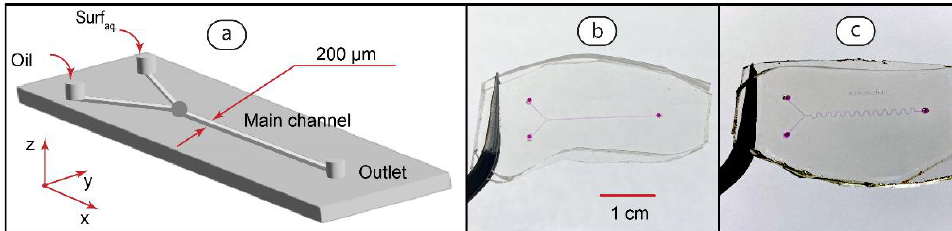
Figure 2. Design of Y-type microfluidic chips for testing the formation of droplets and threads by individual polymer and surfactant solutions ( a ) and the fabricated devices with the straight ( b ) and serpentine ( c ) main channel geometries. Channels are filled with dye (phenolphthalein in 0.01 M KOH) for visualization.